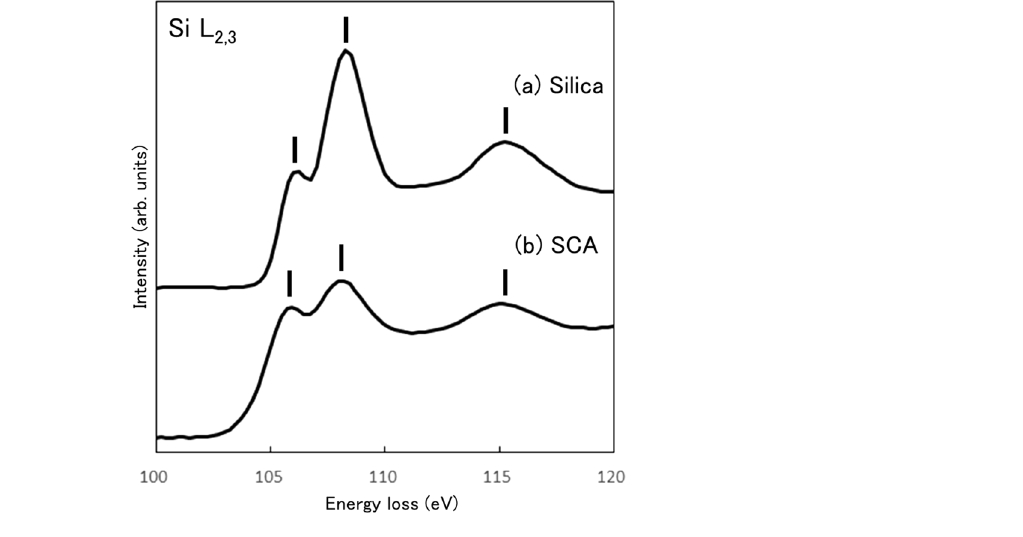
Figure 1. Si-L 2,3 edge EELS spectra of (a) silica and (b)